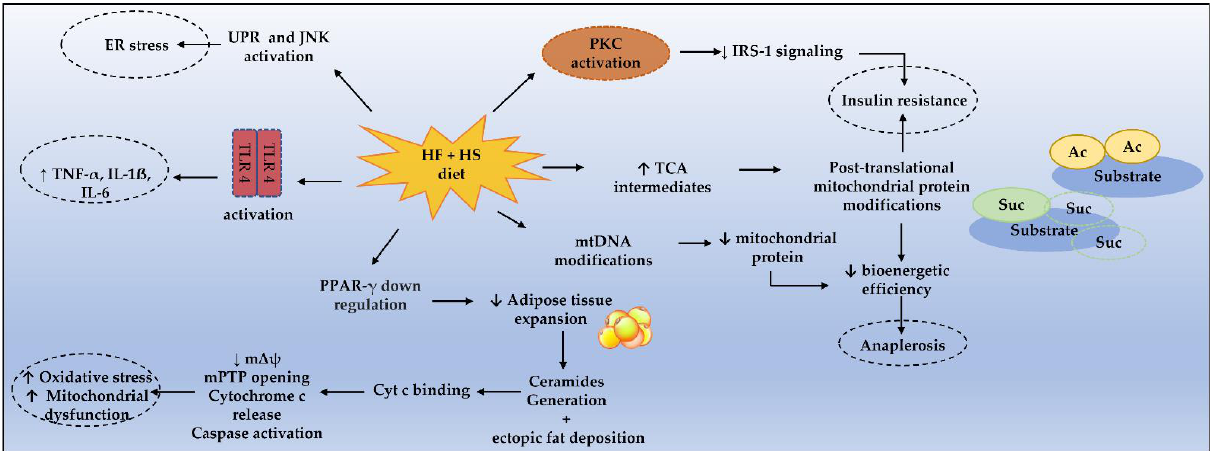
Figure 1. Mechanisms enrolling metabolic dysfunction in MetS. Cyt c, cytochrome c; ER, endoplasmic reticulum; HF, high fat; HS, high sugar; IRS-1, IL-1 ẞ , interleukin 1 ẞ ; IL-6, interleukin 6; insulin receptor substrate 1; JNK, c-Jun N-terminal kinase; mPTP, mitochondrial permeability transition pore; mΔψ, mitochondrial transmembrane potential; PKC, protein kinase C; PPAR- γ, peroxisome proliferator-activated receptor γ; TLR4, toll-like receptor 4; UPR, unfolded protein response, TNF- α, tumor necrosis factor α.